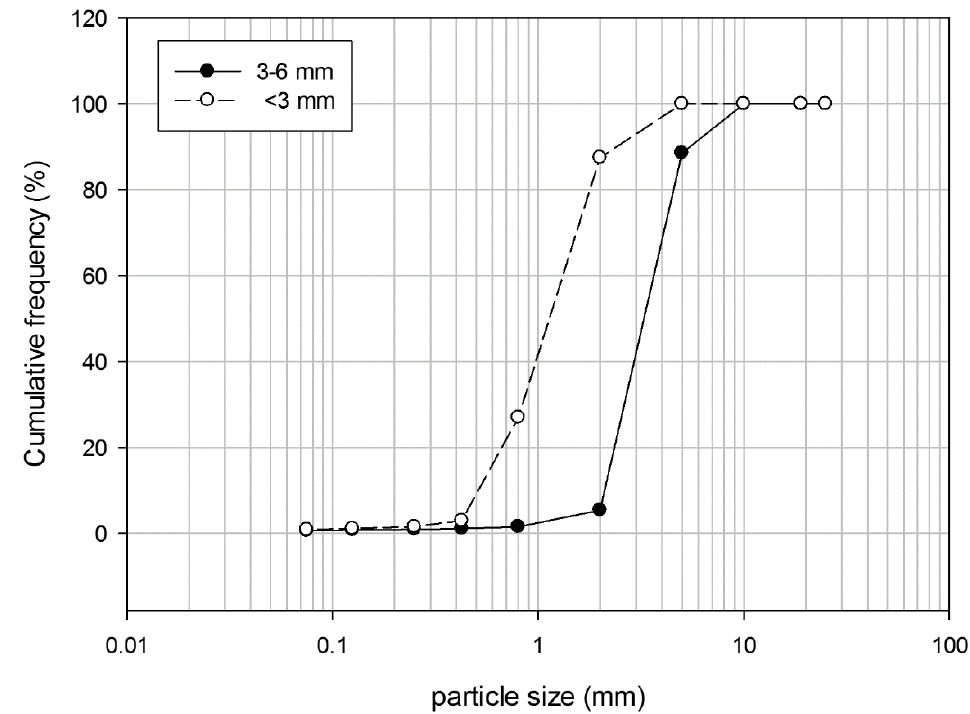
Figure 2. Particle size analysis of the employed zeolitites.